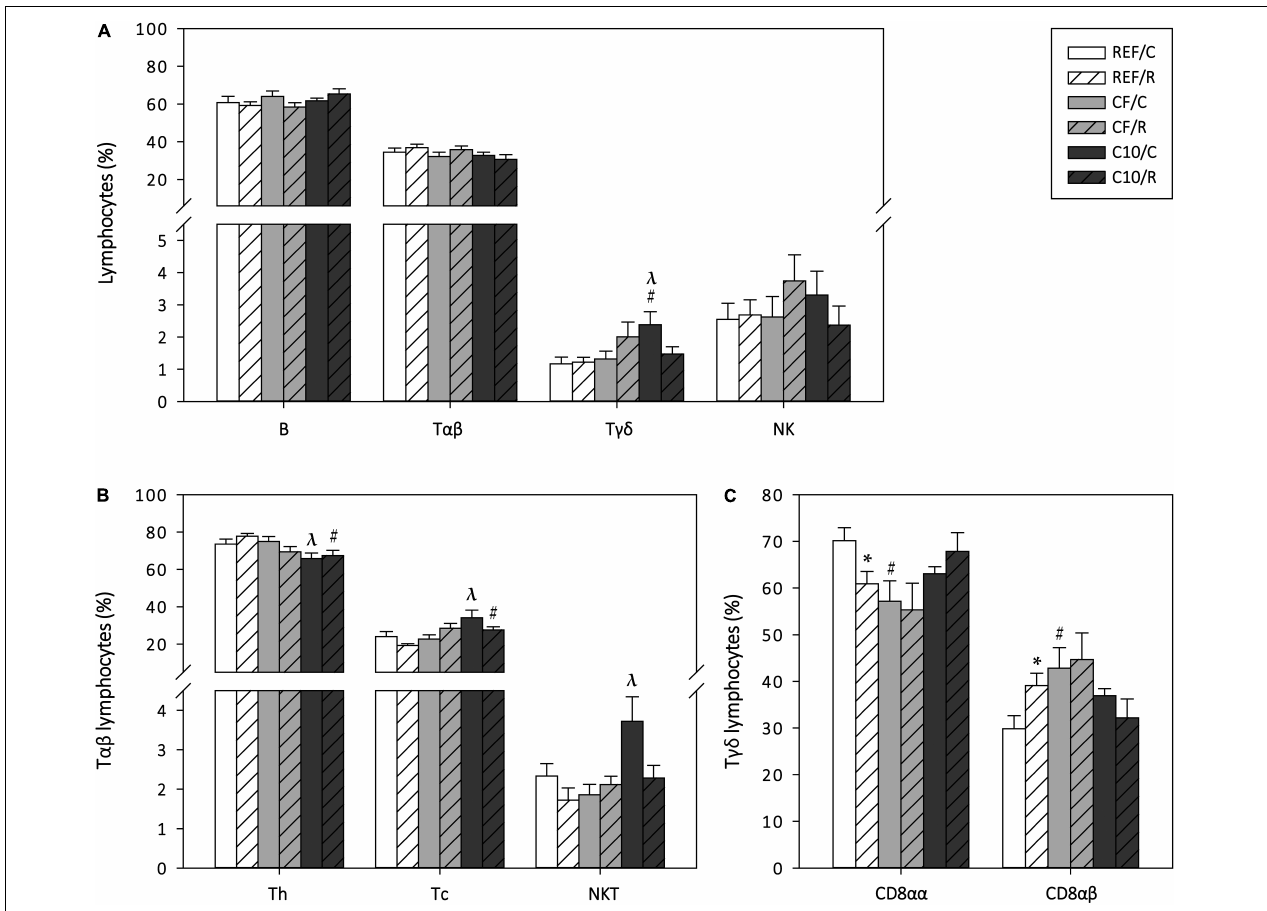
FIGURE 6 | Peyer‘s patches’ lymphocyte composition: main lymphocyte subsets (A) , T αβ cell subsets (B) and T γδ cell subsets (C) cell proportion. The control (C) groups are represented by smooth bars and the runner (R) groups by striped bars. REF, reference diet; CF, 5% cocoa fiber-enriched diet; C10, 10% cocoa-enriched diet. Data are expressed as mean ± SEM ( n = 8). Statistical differences (Kruskal-Wallis followed by Dunnet’s test): * p < 0.05 vs. the C group in the same diet; # p < 0.05 vs. the same exercise condition in the REF diet; λ p < 0.05 vs. the same exercise condition in the CF